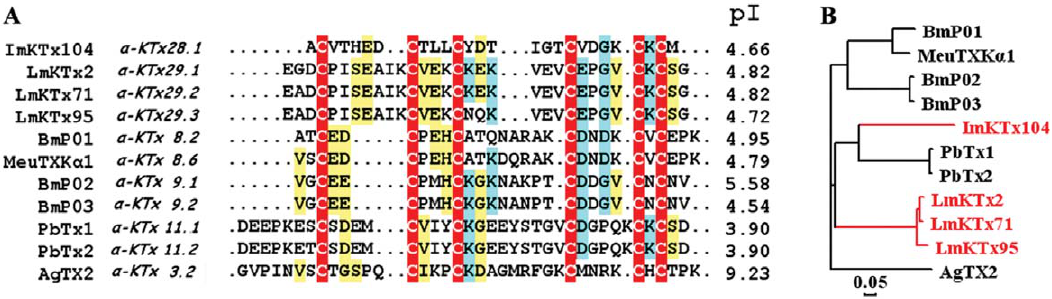
Figure 2. New subfamilies of acidic a -KTx28 and a -KTx29. (A) Multiple sequence alignment of ImKTx104, LmKTx2, LmKTx71, and LmKTx95 with other a -KTxs; (B) Phylogenetic tree of four new acidic toxins with other known acidic a -KTxs.